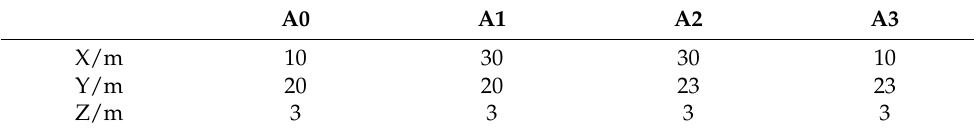
Table 3. Base station coordinates in a passage simulation